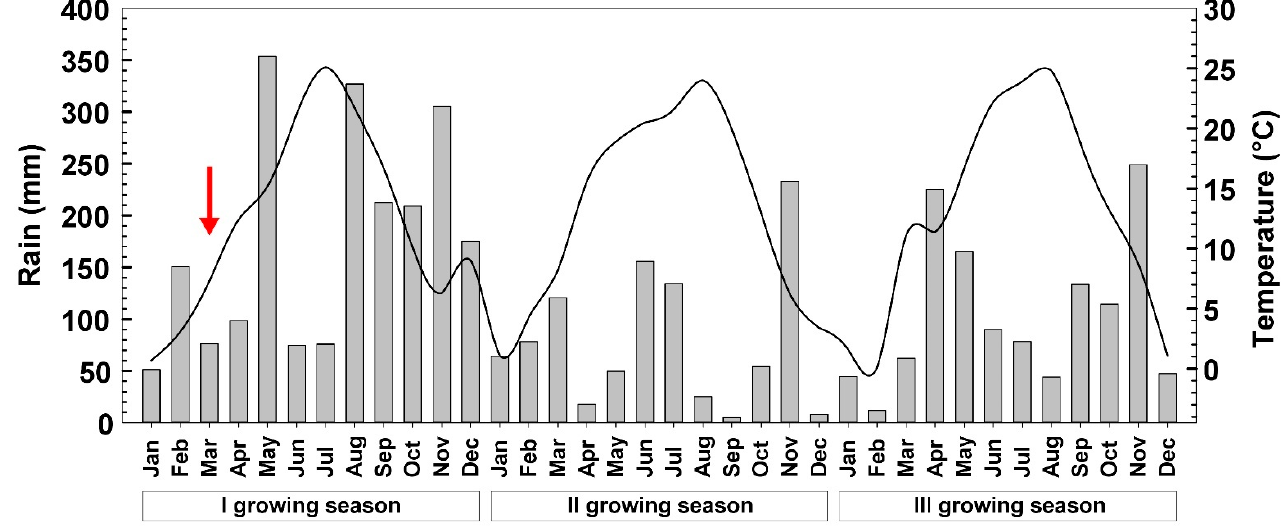
Figure 1. Air temperatures and precipitation at the experimental area during the research (first, second and third growing seasons after transplanting plants from the nursery to the field). The red arrow indicates the month of transplanting in the